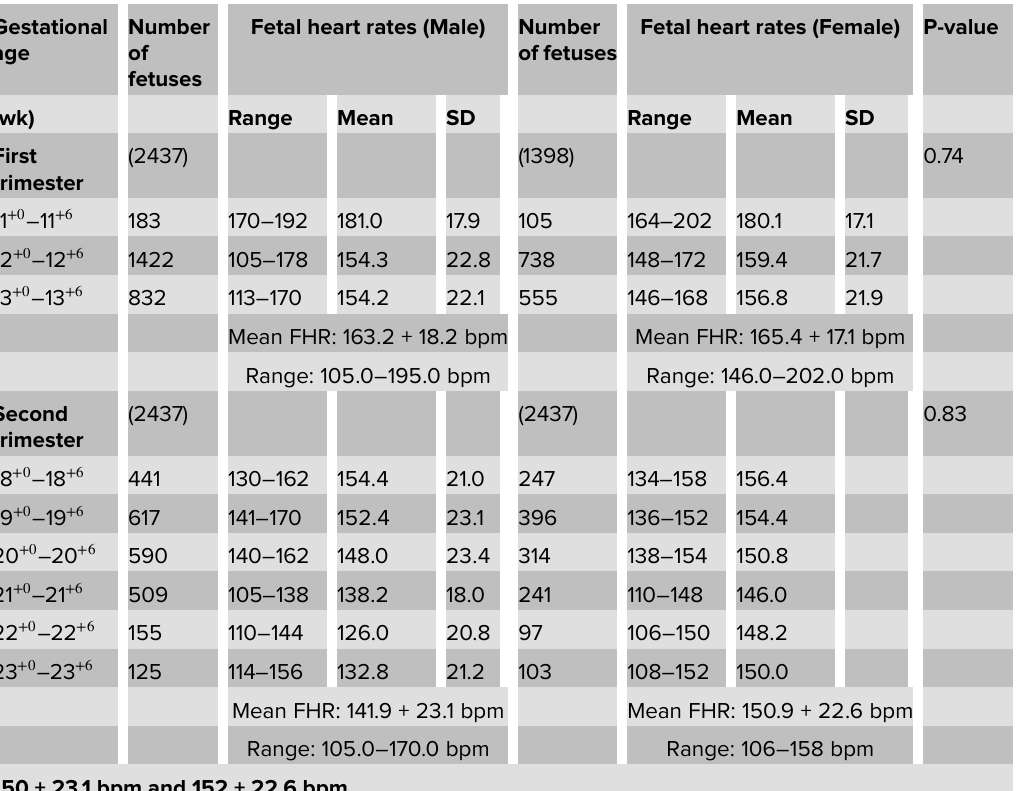
Table 1: Analysis of pattern of fetal heart rates in first and second